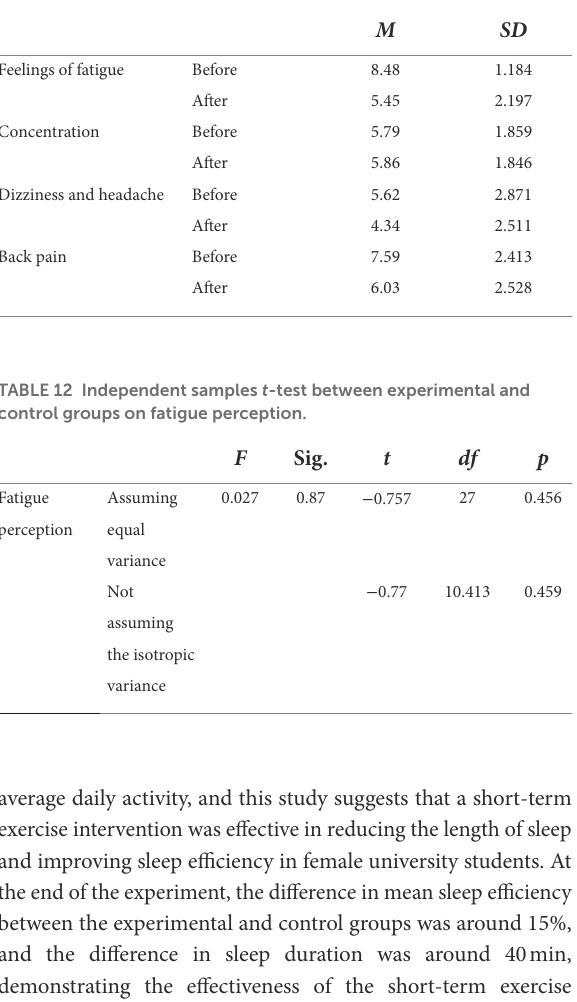
TABLE 11 Comparison of fatigue feeling, concentration, dizziness and headache, and back pain in the experimental group before and after the intervention.